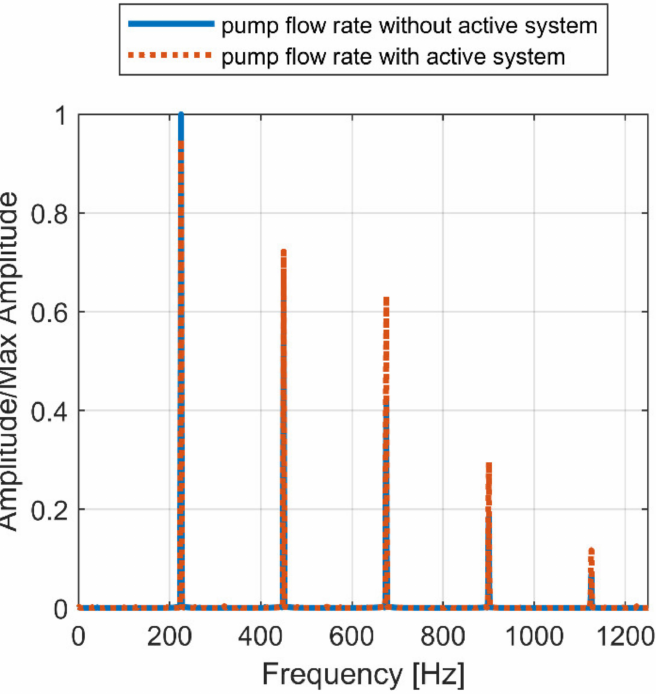
Figure 27. Simulation cycle 2, section 3: flow ripple FFT at 220 bar, 1500 rpm, 50% swash plate